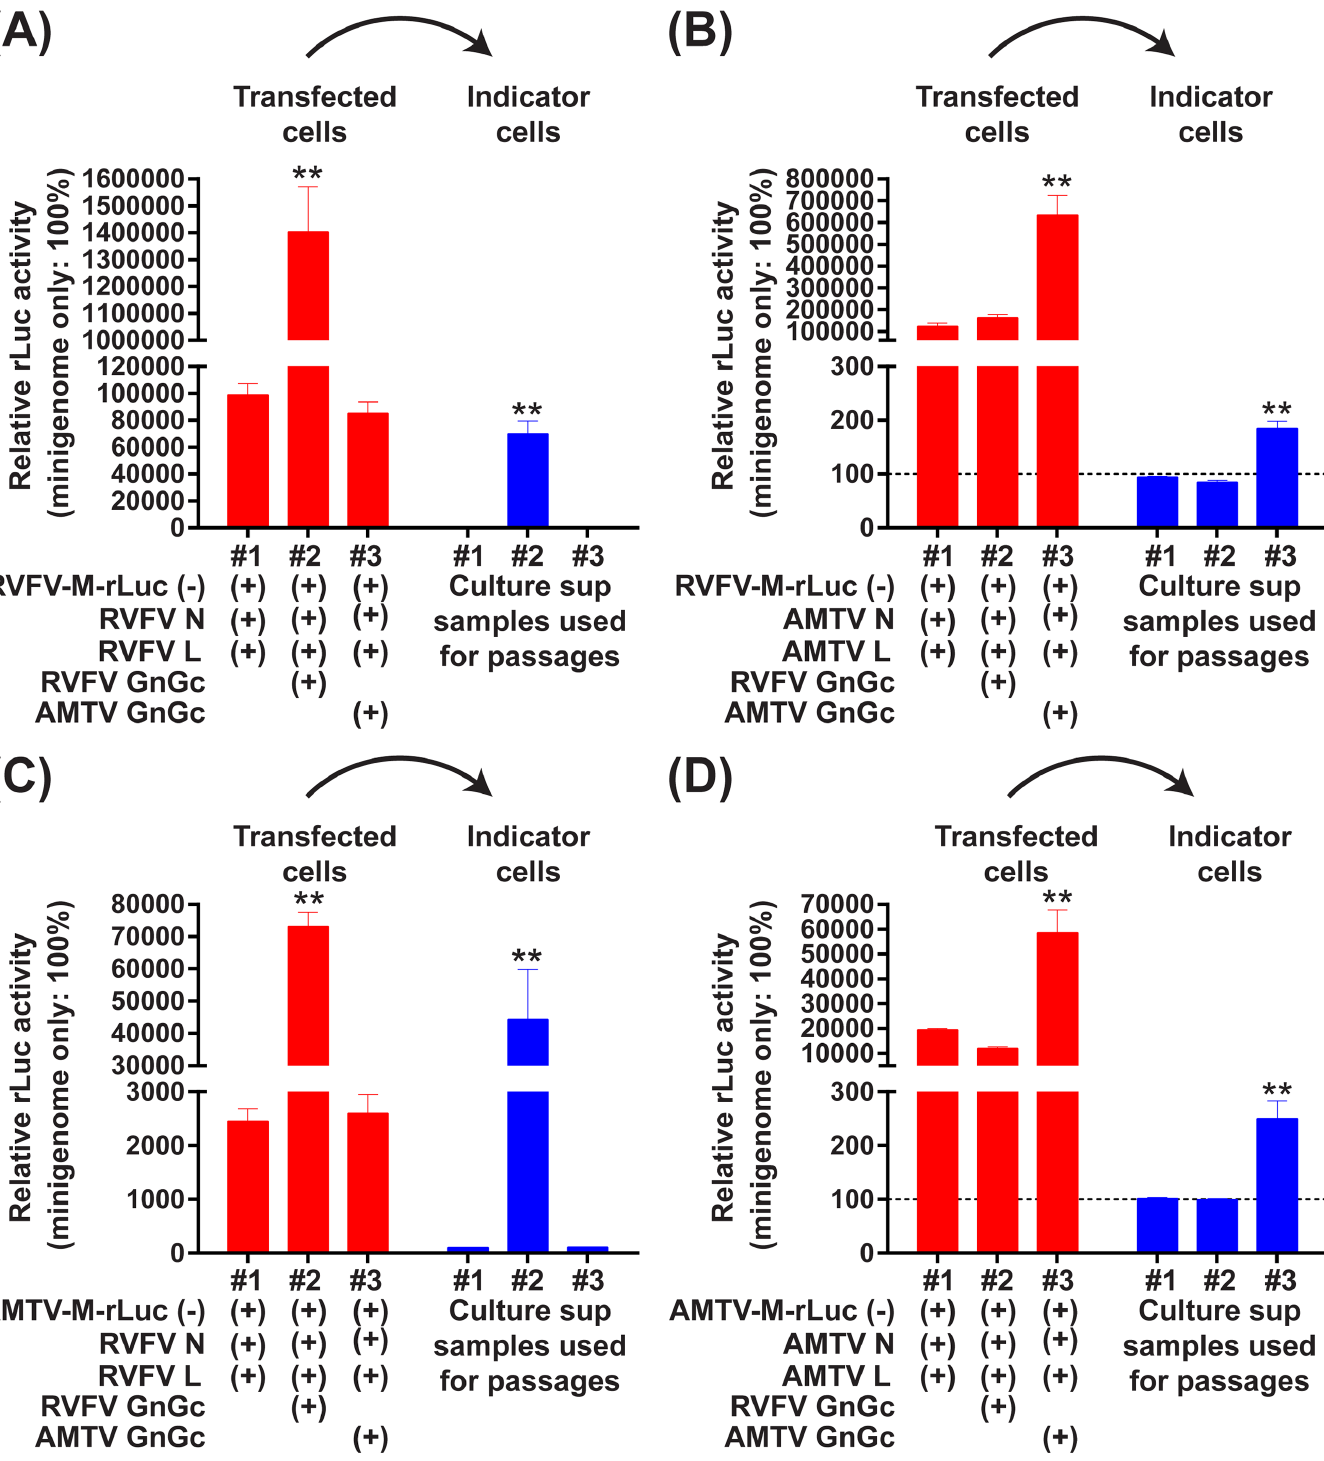
Fig 4. Minigenome assayswith expressions of N, L, and Gn/Gc proteins derived from Arumowot virus (AMTV) or Rift Valley fever phlebovirus (RVFV). BHK/T7-9 cells were transfected with plasmidsexpressingM-segment minigenome RNA from either RVFV (A and B) or AMTV (C and D). Those cells were also co-transfected with plasmidsexpressingN and/or L derivedfrom either RVFV (A and B) or AMTV (C and D), as well as those expressingGn/ Gc proteinsderived from either AMTV or RVFV. The rLuc activity was measuredat 72 hpt. Culture supernatants from transfected cells were transferred into fresh Vero cells transduced with adenovirus vectors expressingRVFV N and L proteins for 2 hours immediately before incubationwith supernatants. The rLuc